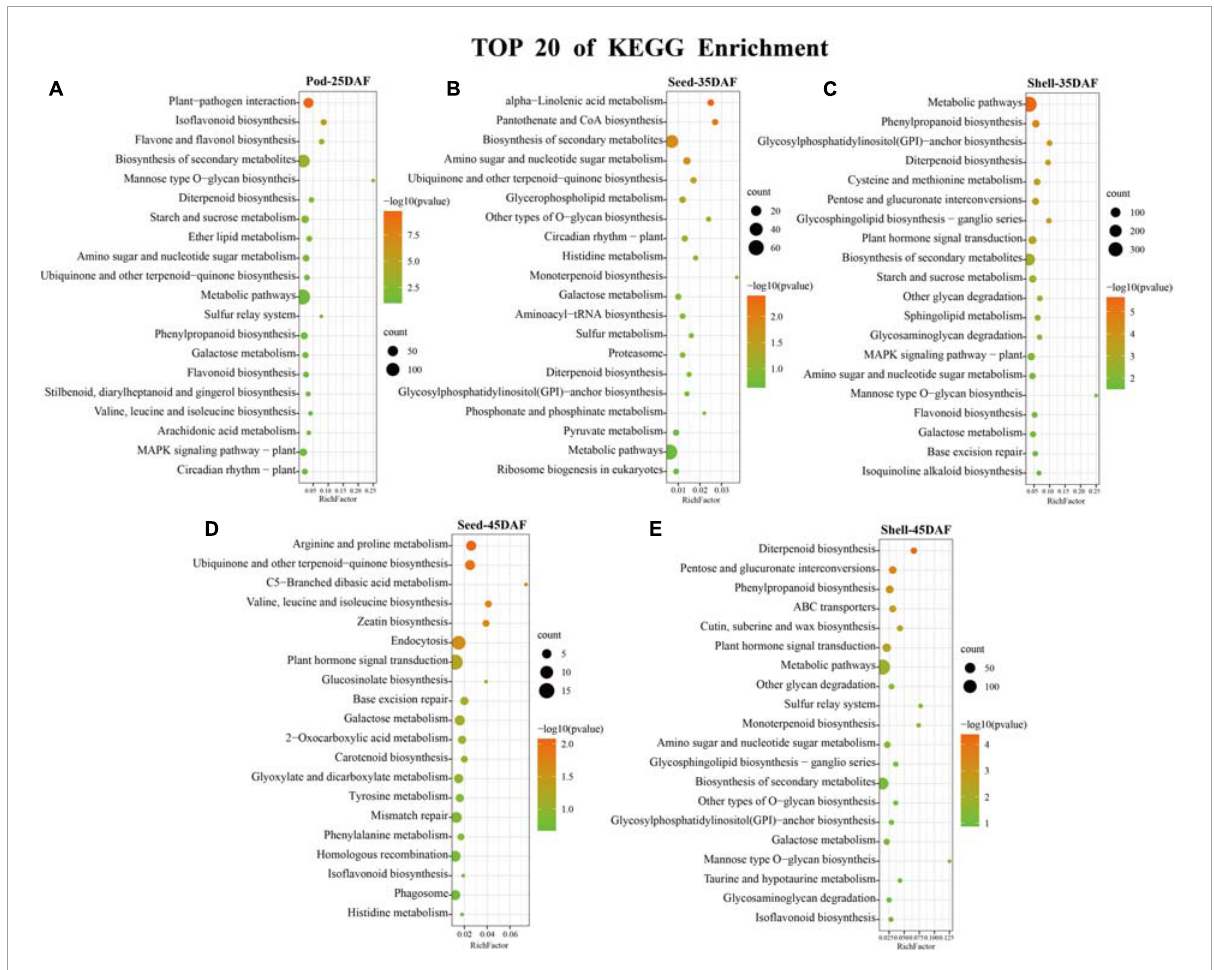
FIGURE5 Kyoto Encyclopedia of Genes and Genomes (KEGG) Enrichment analysis. (A–E) Top 20 pathways of KEGG enrichment results in five phases: Pod-25, Seed-35, Shell-35, Seed-45, and Shell-45 DAF. The color scale indicates significance (corrected p -value). The size of the circle represents the number of genes enriched by that